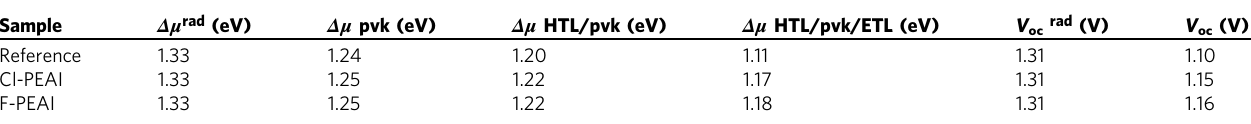
Table 1 Values of radiative QFLS Δ µ rad ; QFLS Δ µ for the different stacks (neat perovskite (pvk), half cells (glass/ITO/PTAA/ pvk) and full stacks (glass/ITO/PTAA/pvk/PCBM/BCP)); V oc rad and V oc for reference, Cl-PEAI and F-PEAI